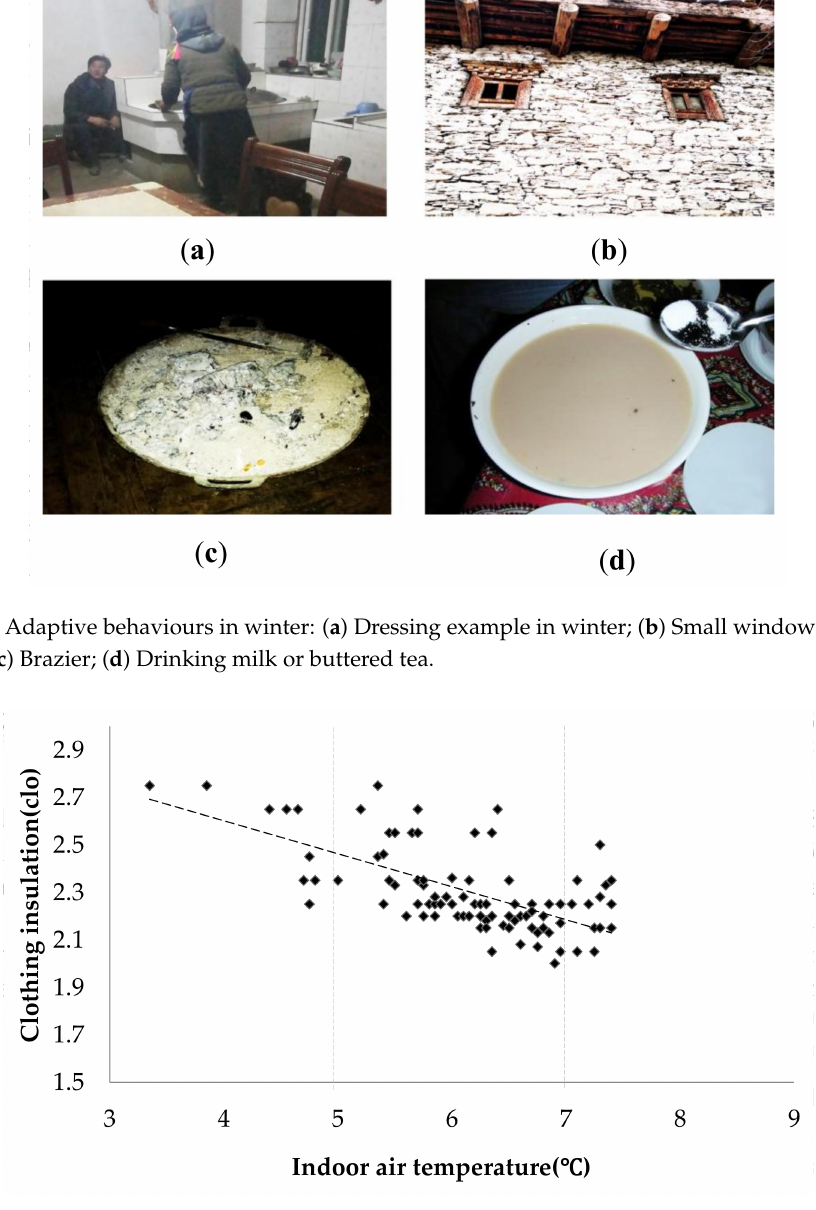
Figure 10. Correlation between resident clothing insulation and indoor air temperature in